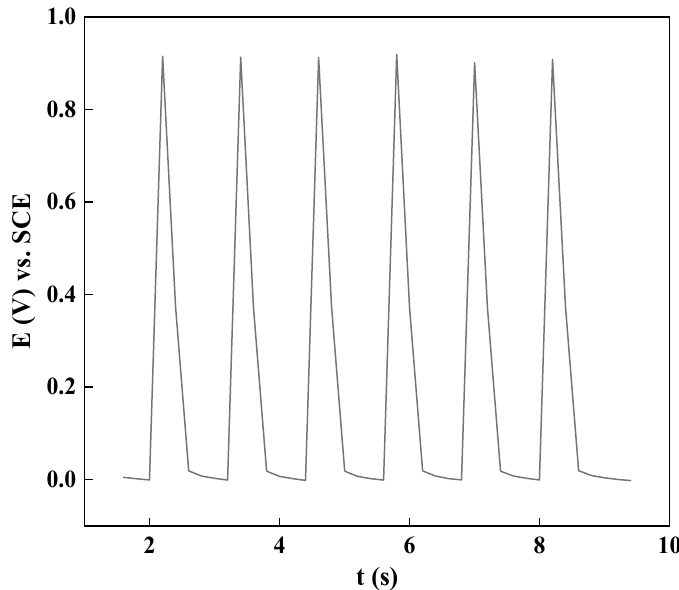
Figure 10. The charge-discharge curve of the prepared samples.